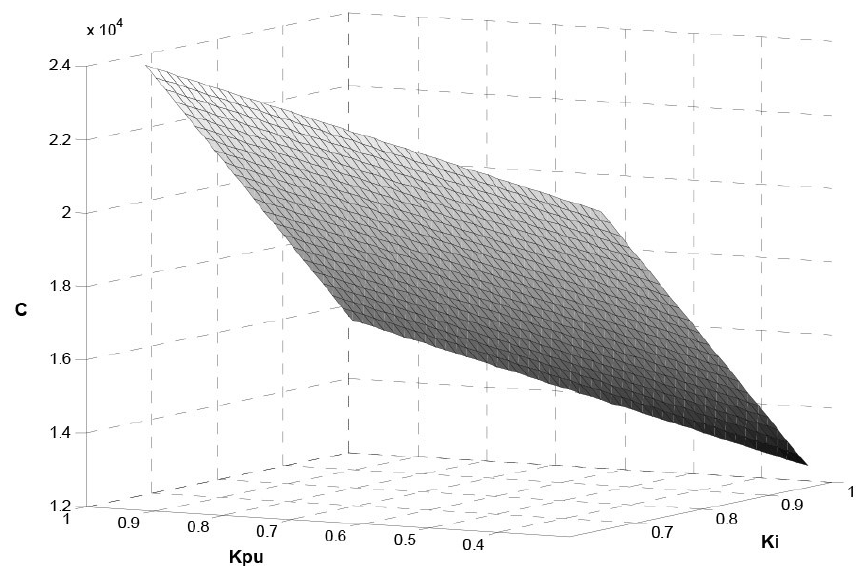
Figure 6. Location of safety stock-Case 1